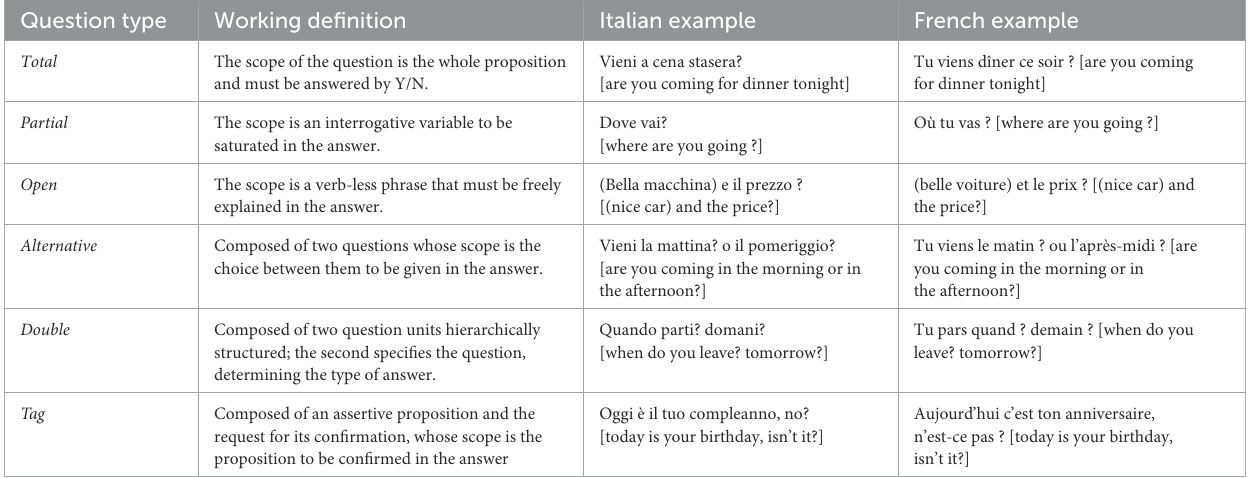
TABLE 3 Question types adopted for corpus